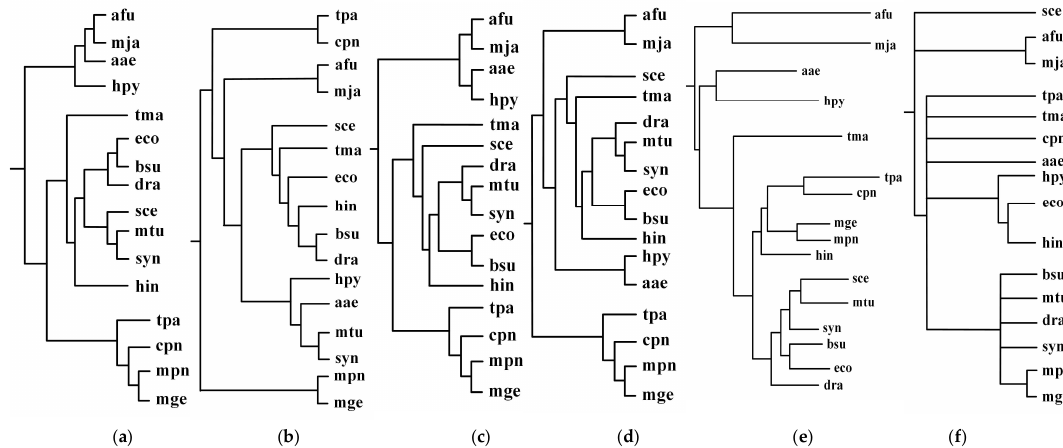
Figure 2. Incremental phylogenetic reconstruction for 16 organisms from their common metabolic pathways. ( a ) Our tree T 1 based on aligning 5 common pathways for 16 organisms. ( b ) Our tree T 2 based on aligning 10 common pathways for 16 organisms. ( c ) Our tree T 3 based on aligning 15 common pathways for 16 organisms. ( d ) Our tree T 4 based on aligning 20 common pathways for 16 organisms. ( e ) Heymans et al . ’s tree for 16 organisms. ( f ) The NCBI taxonomy for 16 organisms.